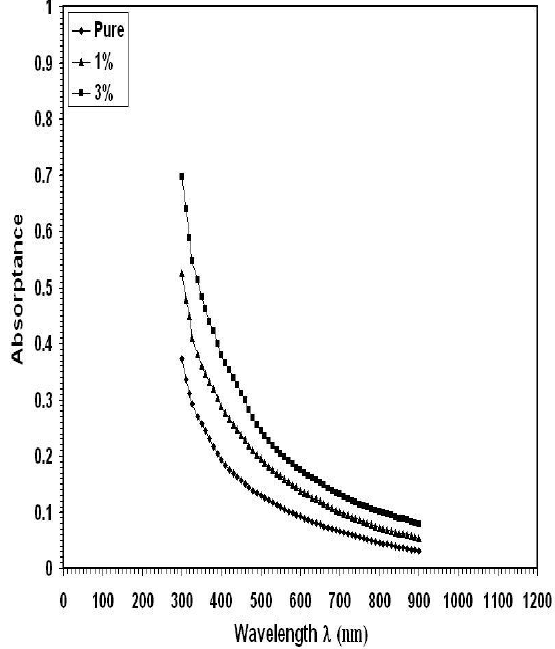
Fig. 1: Absorptance spectra versus wavelength.